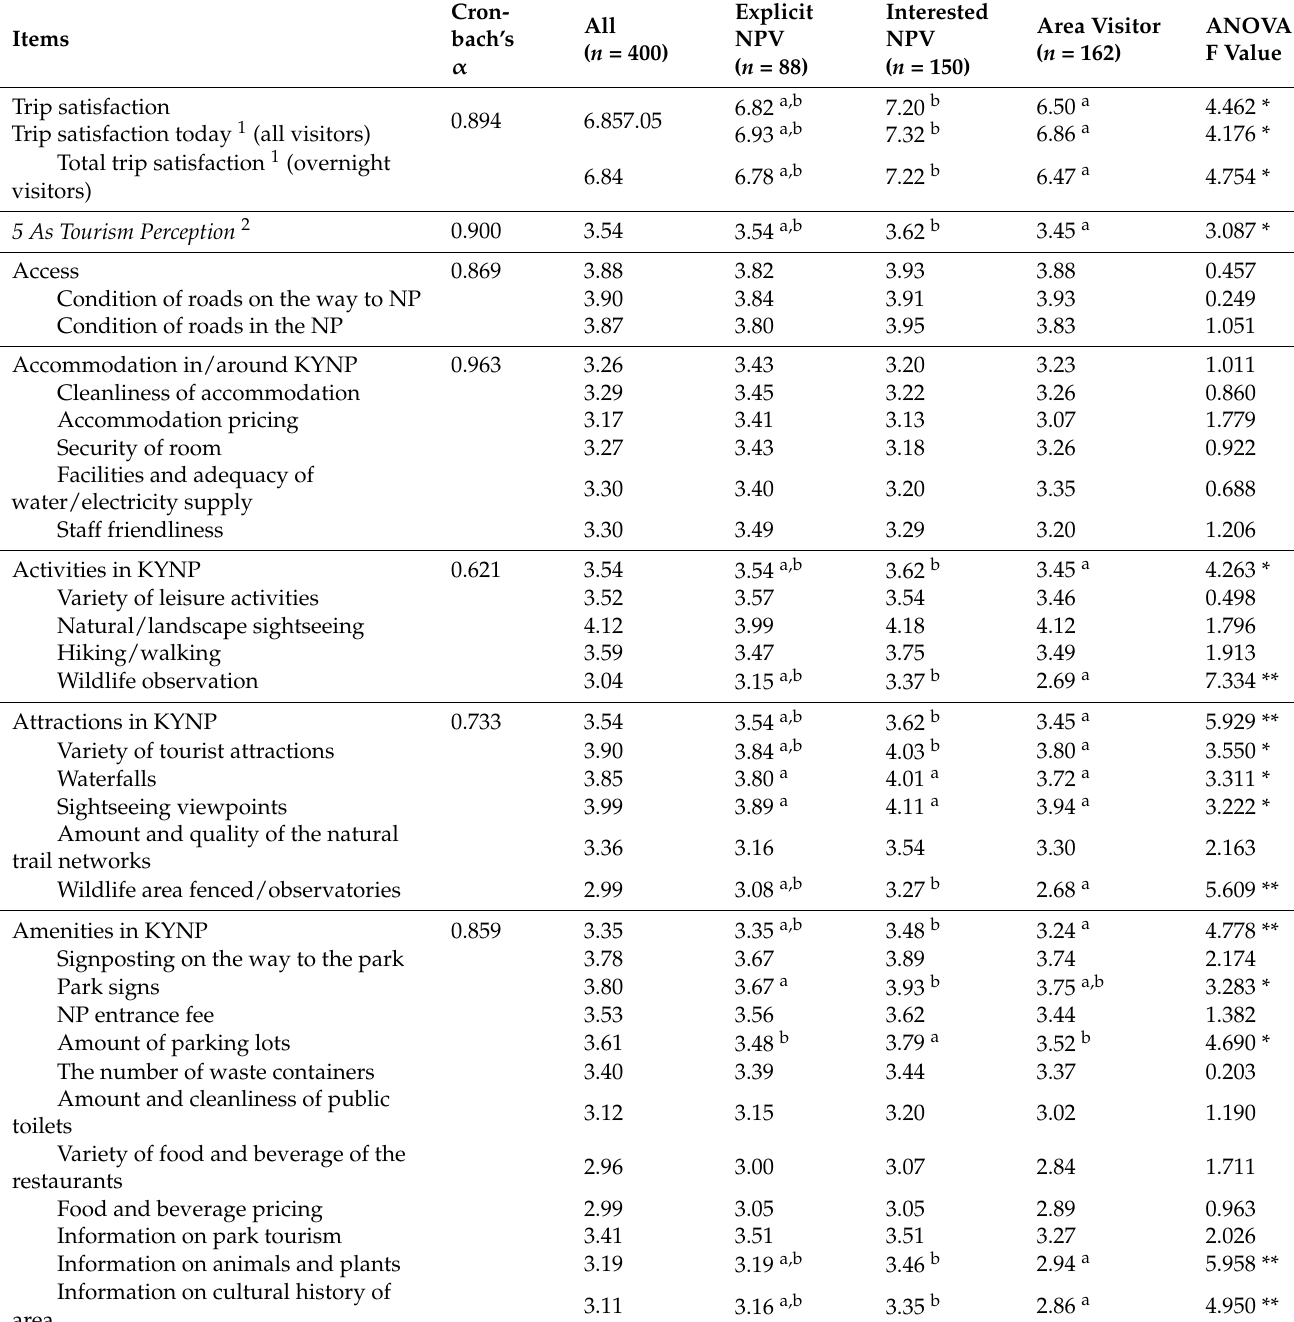
Table 4. Visitor satisfaction with trip, park services and facilities and per affinity